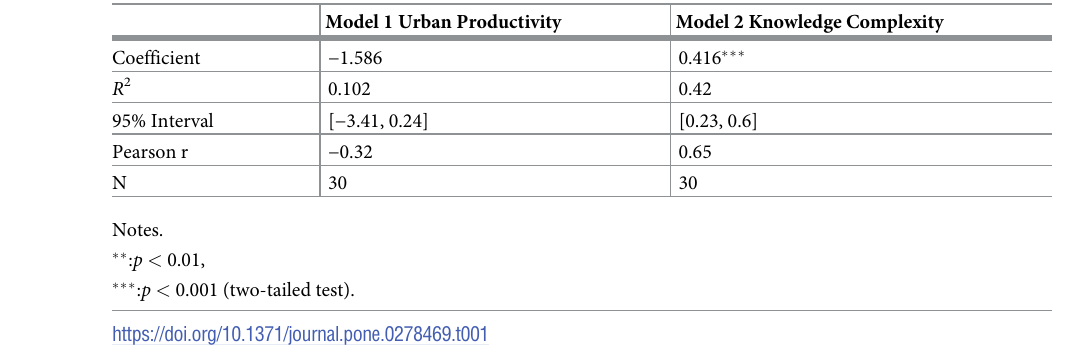
Table 1. Regression results: Effects of urban productivity and complexity on urban